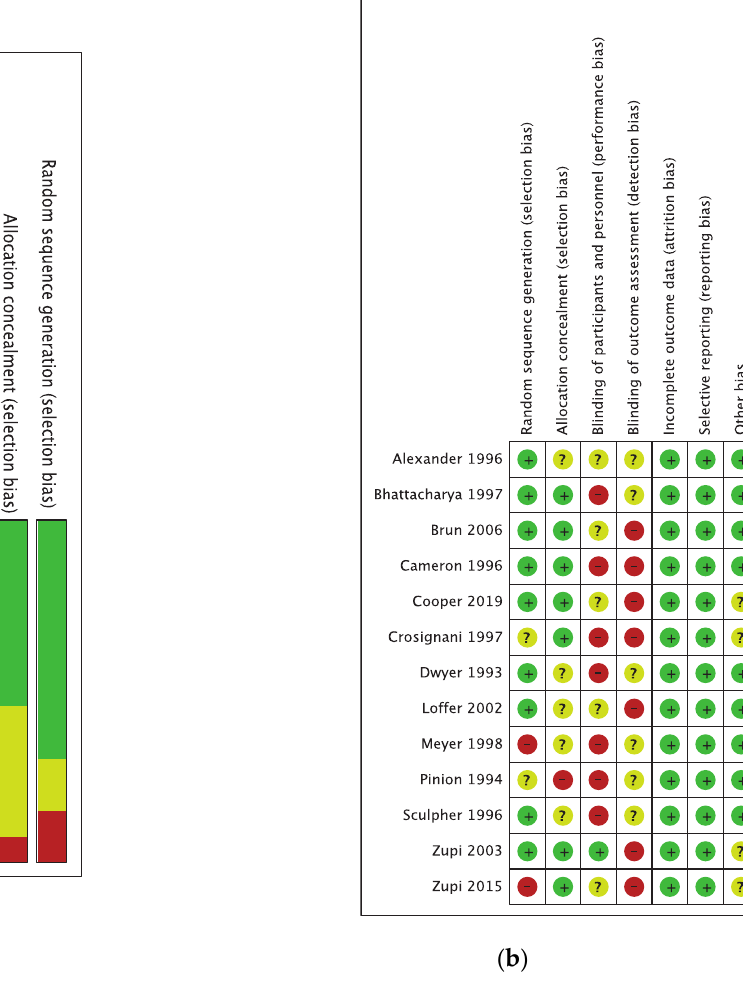
Figure 2. Risk of bias in included RCTs according to Cochrane criteria. ( a ) Summary graph. ( b ) Detailed study-by-study assessment. Plus sign: low risk of bias; minus sign: high risk of bias; question mark: unclear risk of bias.